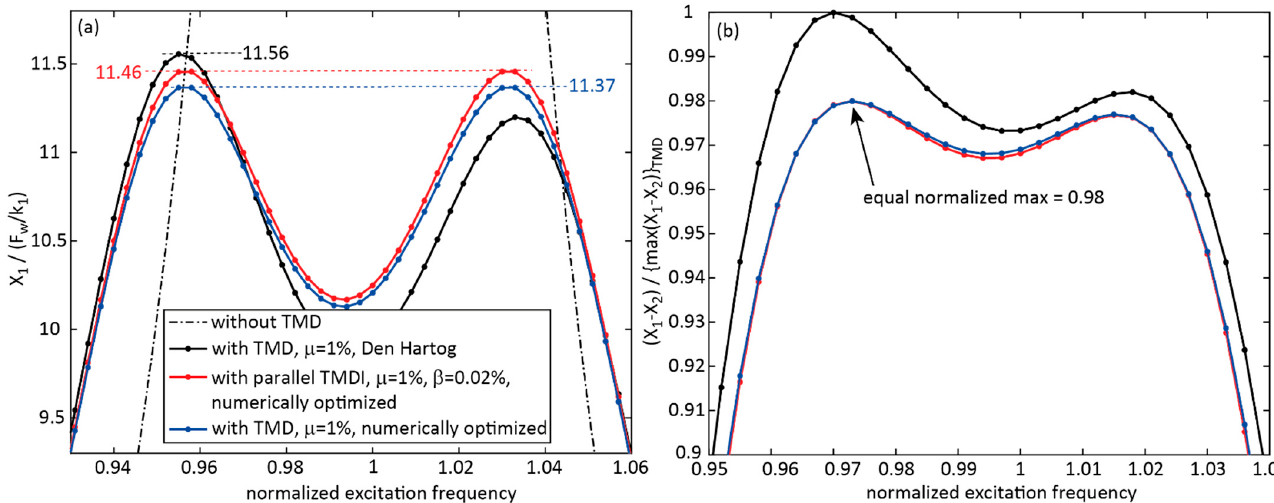
Figure 8. Performances of TMDI with inerter in parallel to stiffness and viscous damper ( µ = 1%, β = 0.02%, numerically optimized parameters), TMD ( µ = 1%, Den Hartog parameters) and TMD ( µ = 1%, numerically optimized parameters) for harmonic excitation: ( a ) primary structure normalized displacement response and ( b ) normalized damper relative motion response.